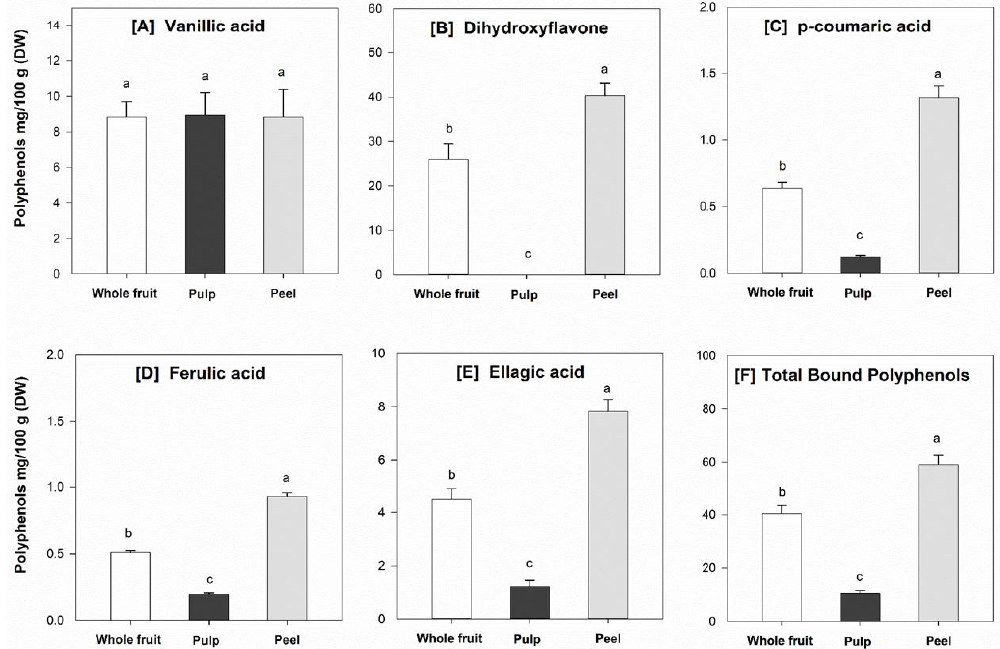
Figure 4. Bound (main) phenolic compounds, including ( A ) vanillic acid, ( B ) dihydroxyflavone, ( C ) p-coumaric acid, ( D ) ferulic acid, ( E ) ellagic acid, and ( F ) total amount of bound polyphenols in the powdered feijoa fruit samples. Data are means ± SD, n = 3. Different letters in the same figure indicate significant differences at α = 0.05.